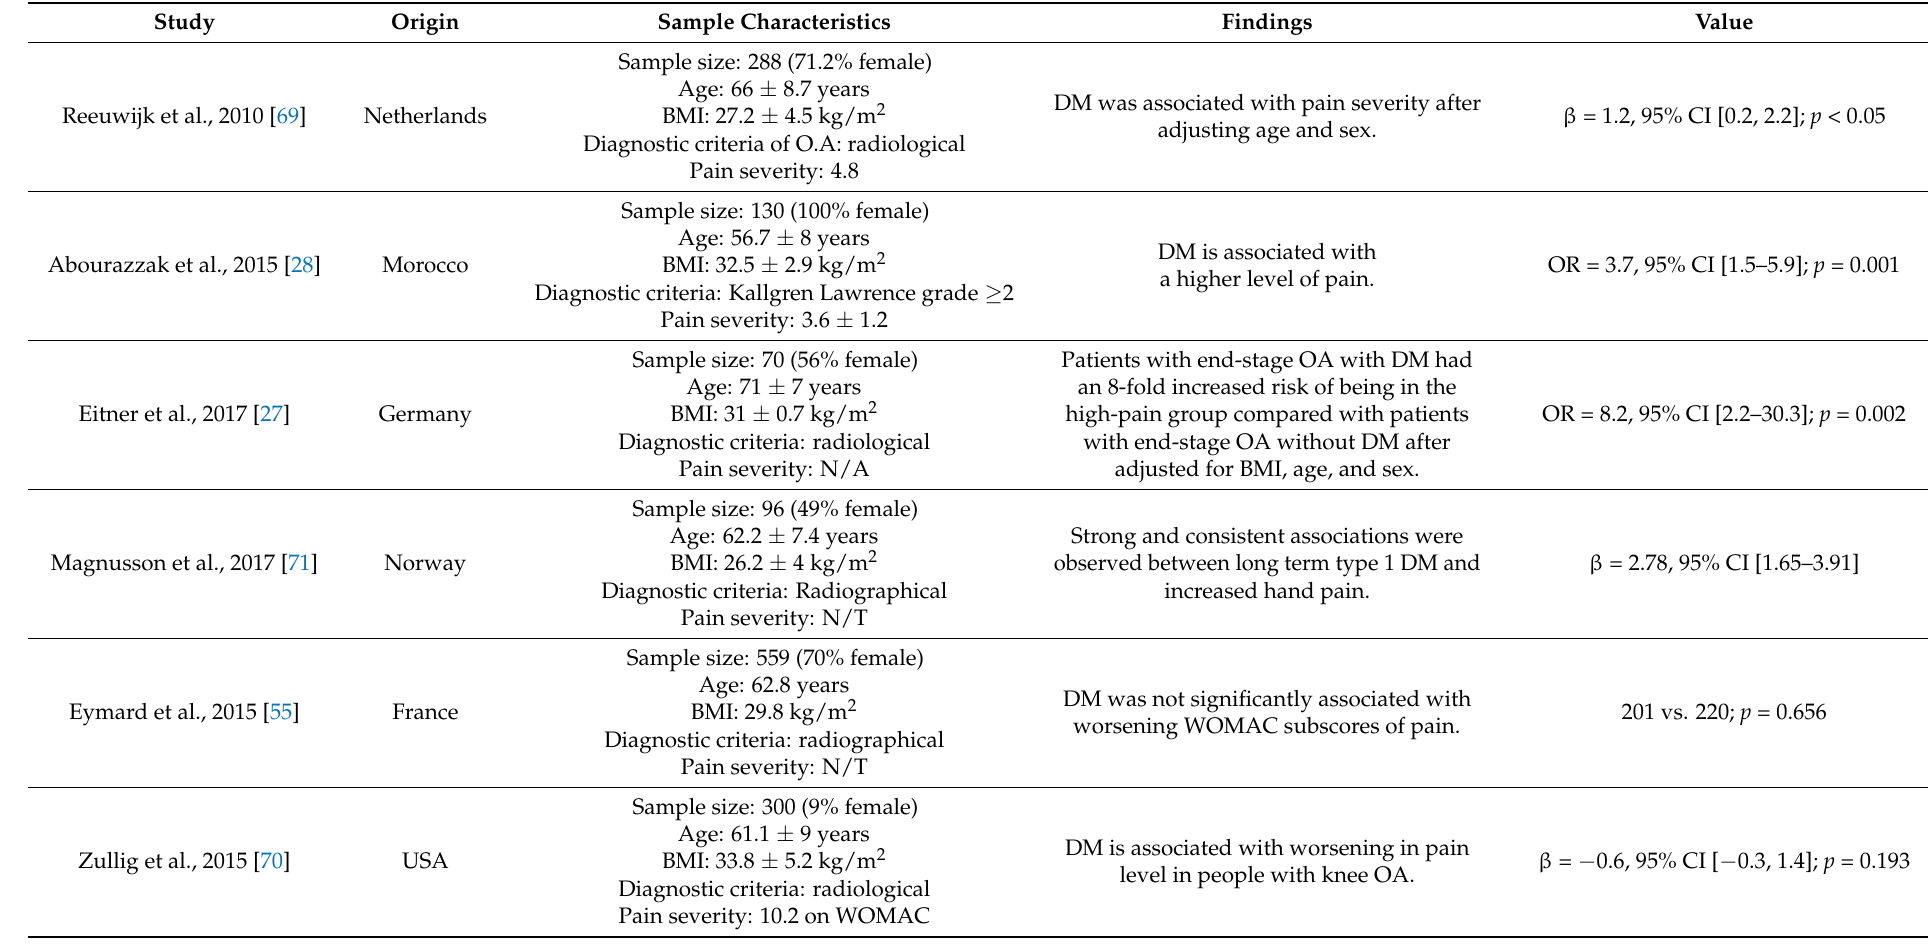
Table 1. Summary of the studies examining the association between osteoarthritis and pain in diabetic individuals.